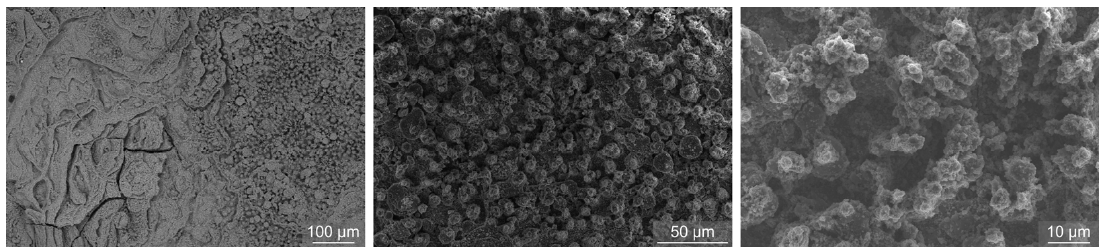
Figure 12. Static contact angle measurements on all surfaces before boiling, after boiling, and after storage.